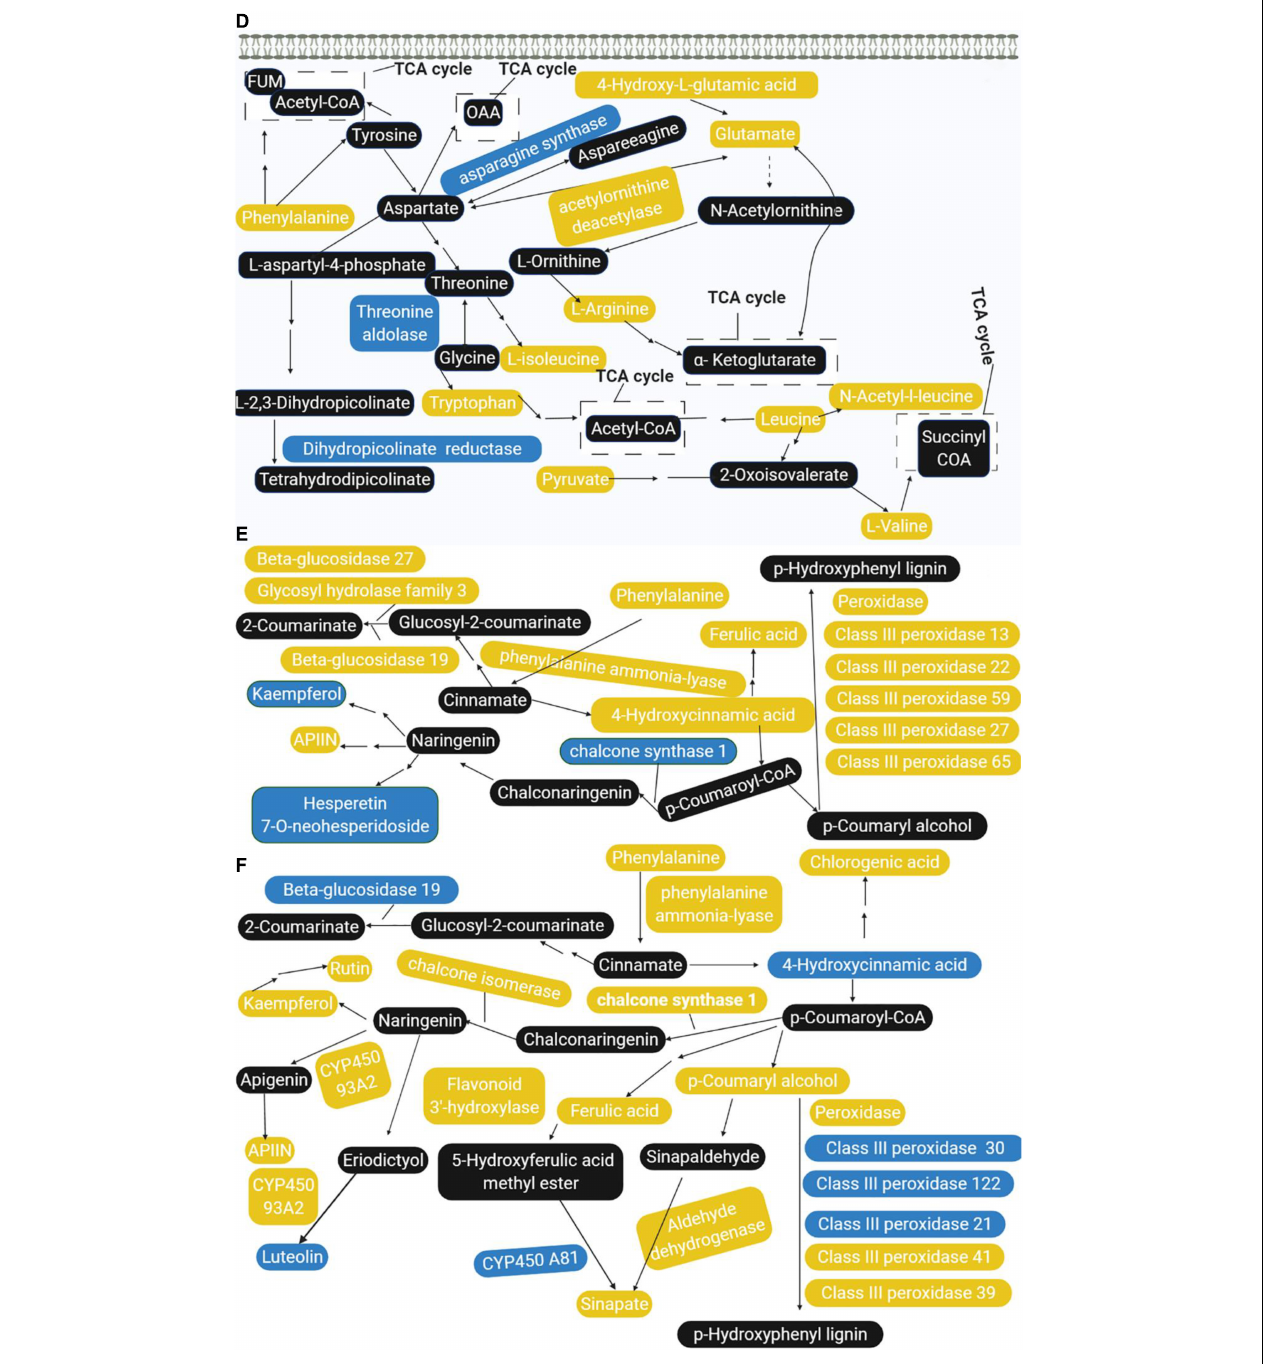
FIGURE 9 | Main biological pathway responses to spaceflight stress in rice progeny. (A) Carbohydrate metabolism and energy metabolism in TLS; (B) carbohydrate metabolism and energy metabolism in TS; (C) amino acid metabolism in TLS; (D) amino acid metabolism in TS; (E) phenylpropane biosynthesis and flavonoid metabolism in TLS; (F) phenylpropane biosynthesis and flavonoid metabolism in TS. The DEPs and metabolites are marked in box; yellow indicates upregulation; blue indicates downregulation; black indicates no significant